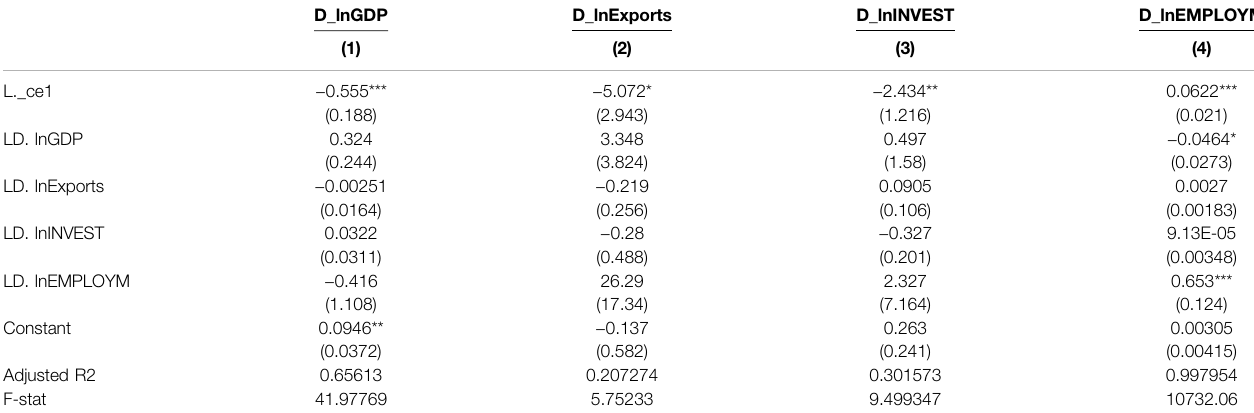
TABLE 7 | Results of the vector error correction models.